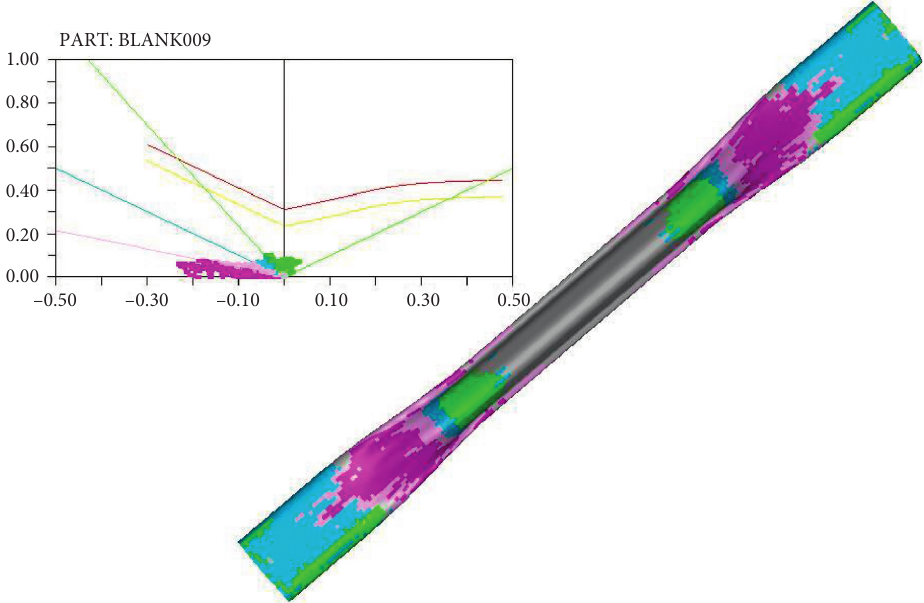
Figure 18: FLD of A